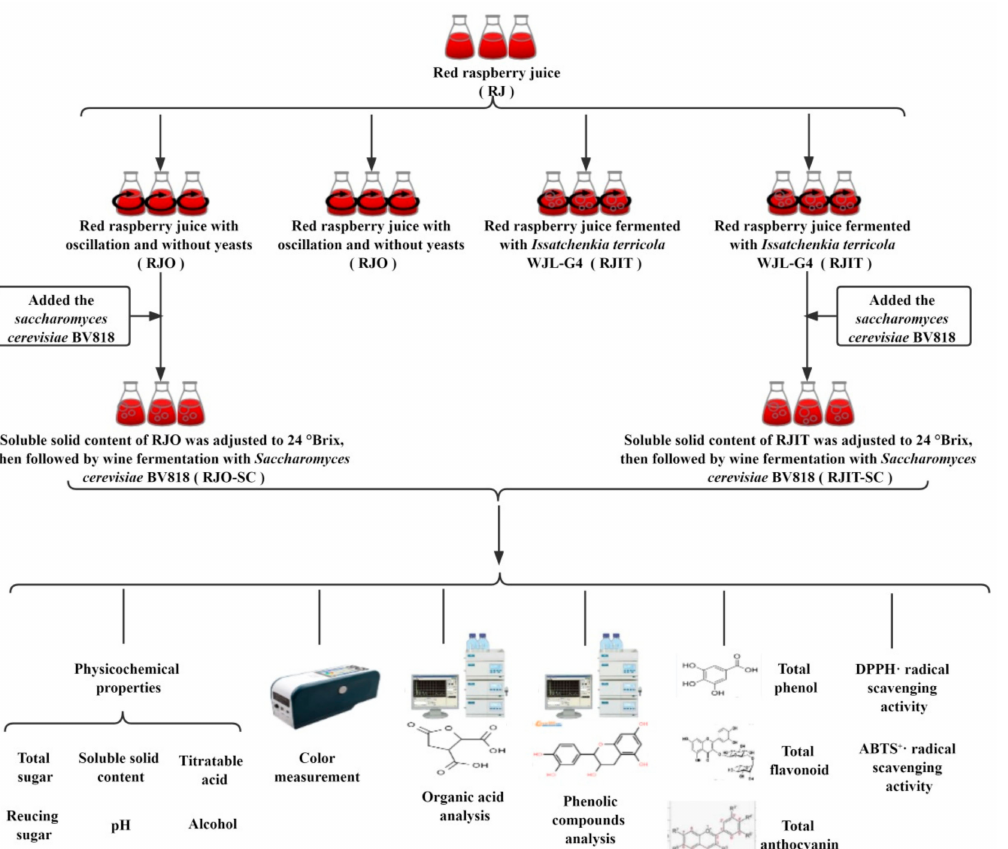
Figure 1. Experimental design of this work. RJ: red raspberry juice; RJO: red raspberry juice with oscillation (28 ◦ C, 36 h, 240 r/min) and without yeasts; RJO-SC: soluble solid content of RJO was adjusted to 24 ◦ Brix, then followed by wine fermentation with S.cerevisiae BV818 (24–26 ◦ C, 15 d,